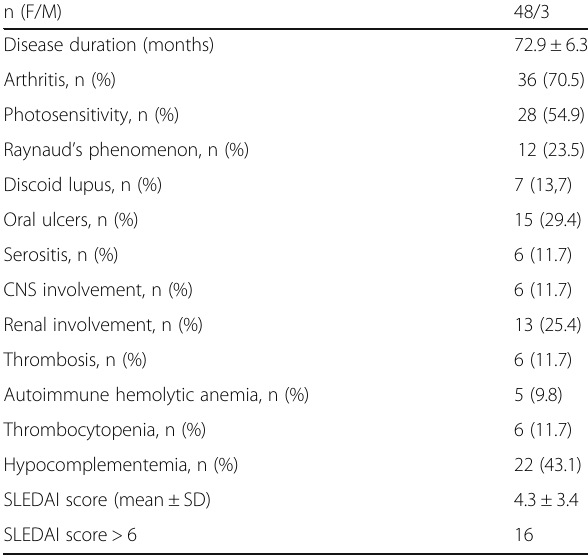
Table 1 Clinical and laboratory characteristics of patients with SLE n (F/M)